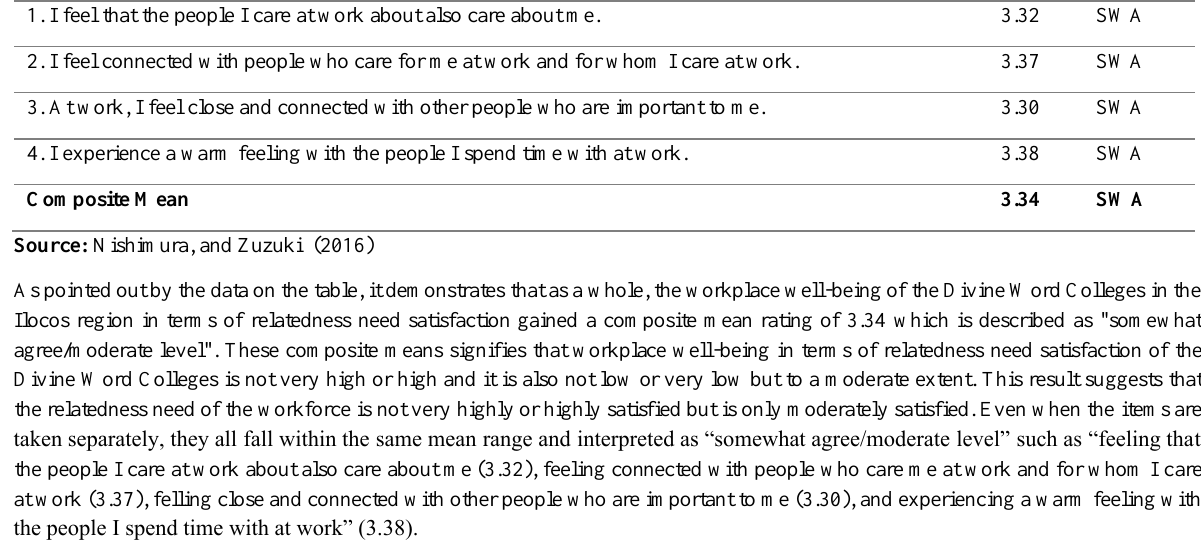
Table 3: The Workplace Well-being of Divine Word Colleges in the Ilocos Region as to Relatedness Need Satisfaction